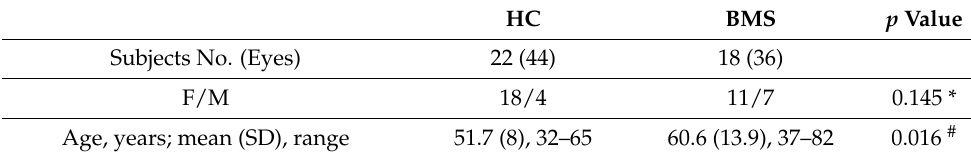
Table 1. Demographic characteristics of the study